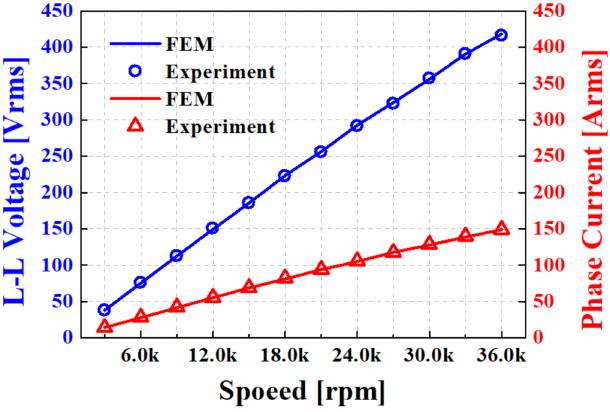
Figure 10. Line to Line voltage and phase current characteristics of Inconel 718 shaft material at